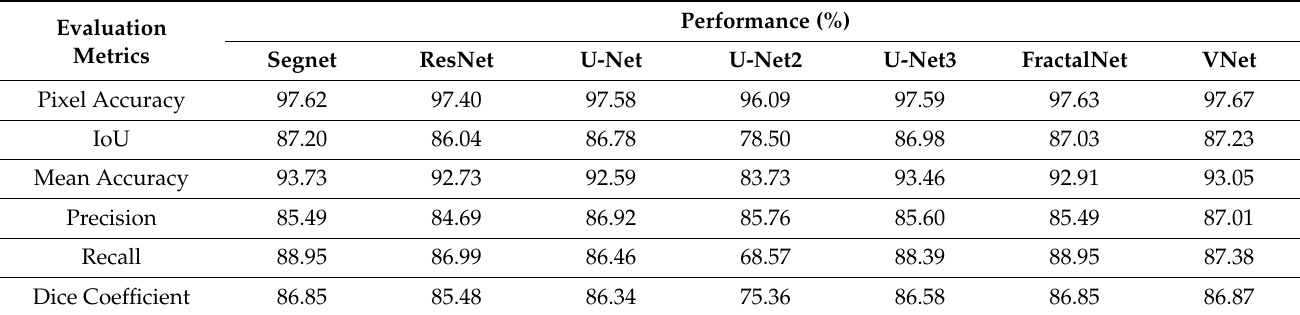
Table 5. Performance measurement with splitting data.